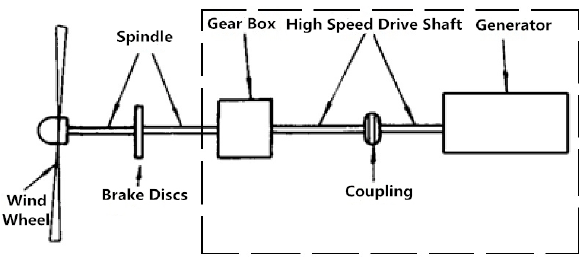
Figure 1. Simplified model of a doubly fed wind turbine.